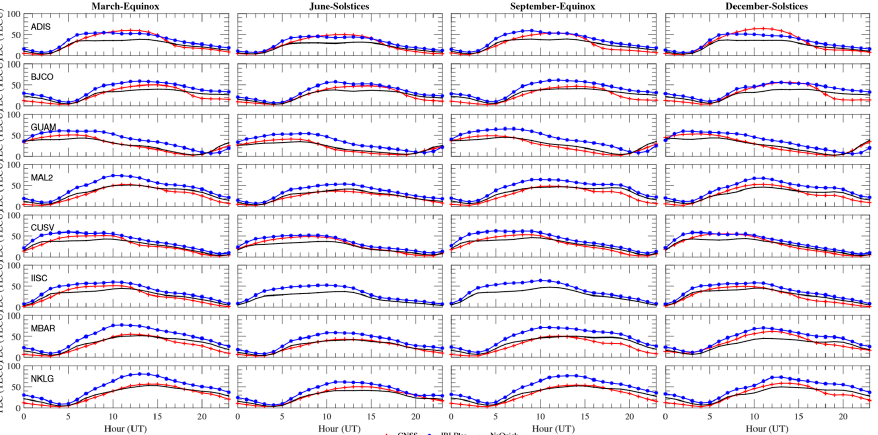
Figure 2. Averaged seasonal variation of GPS-TEC with corresponding modeled TEC for the entire stations considered in 2013.